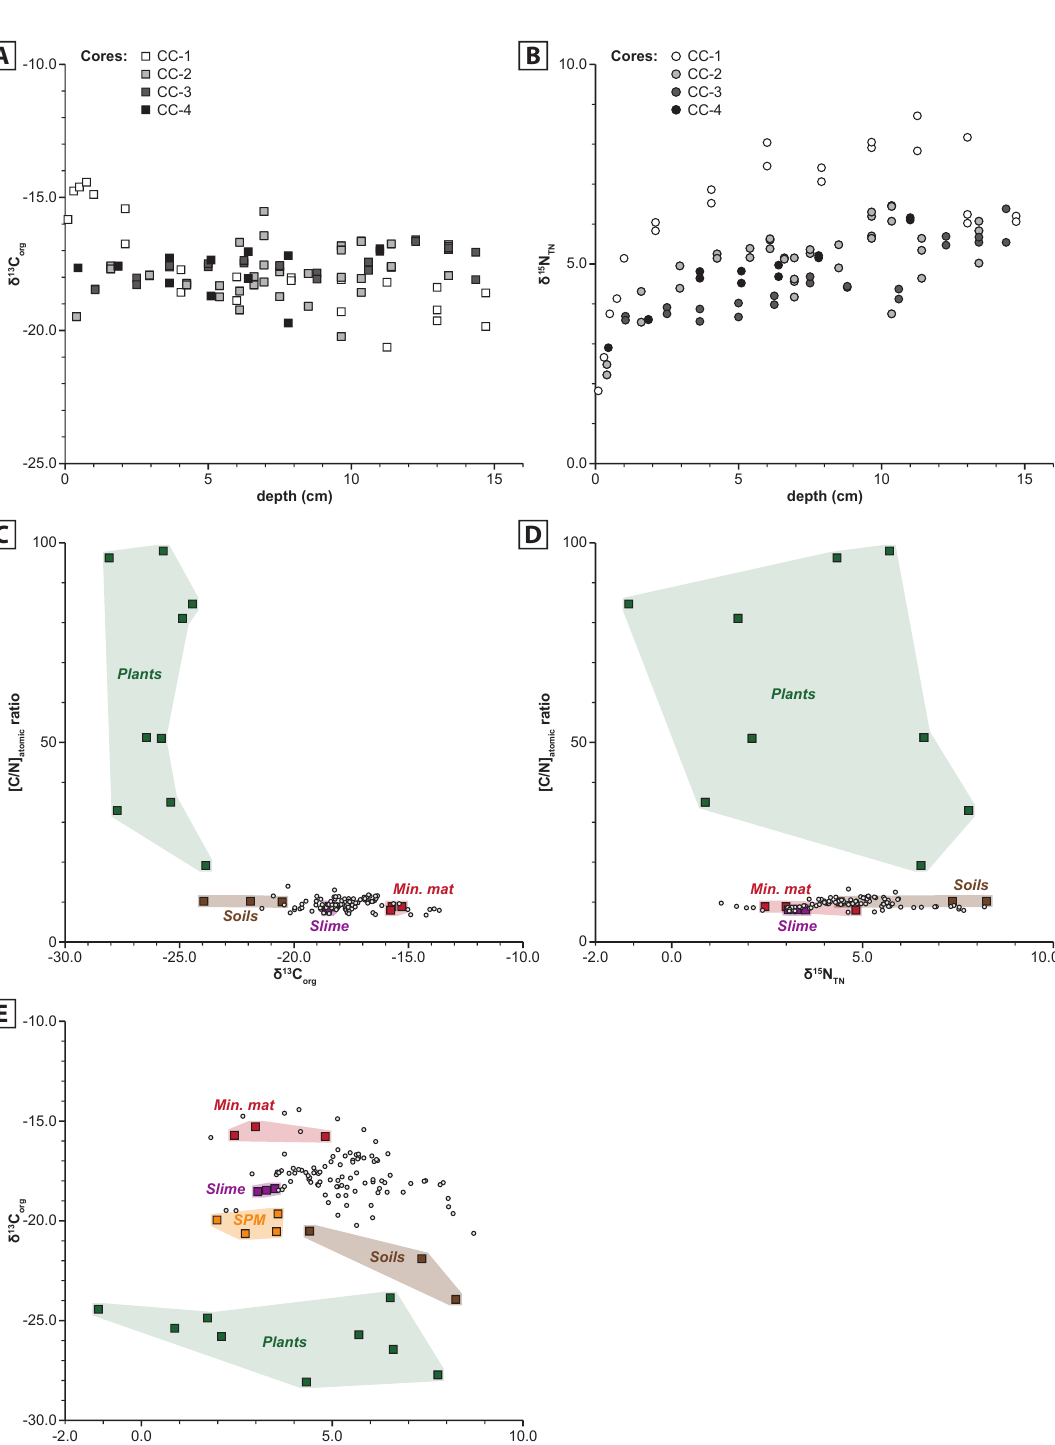
Figure 6. Diagrams showing the evolution of the ( A ) δ 13 C org and ( B ) δ 15 N TN with depth in the four cores (please refer to Figure 2 for the respective locations and Table 2 for numerical values). ( C ) [C / N] atomic ratio vs. δ 13 C org , ( D ) [C / N] atomic ratio vs. δ 15 N TN and ( E ) δ 13 C org vs. δ 15 N TN , values measured in the four cores (light grey circles) compared to the identified source of organic matter in the Cayo Coco lagoonal network (microbial mats: mineralising and slime, suspended particulate matter (only on ( E )), soils and